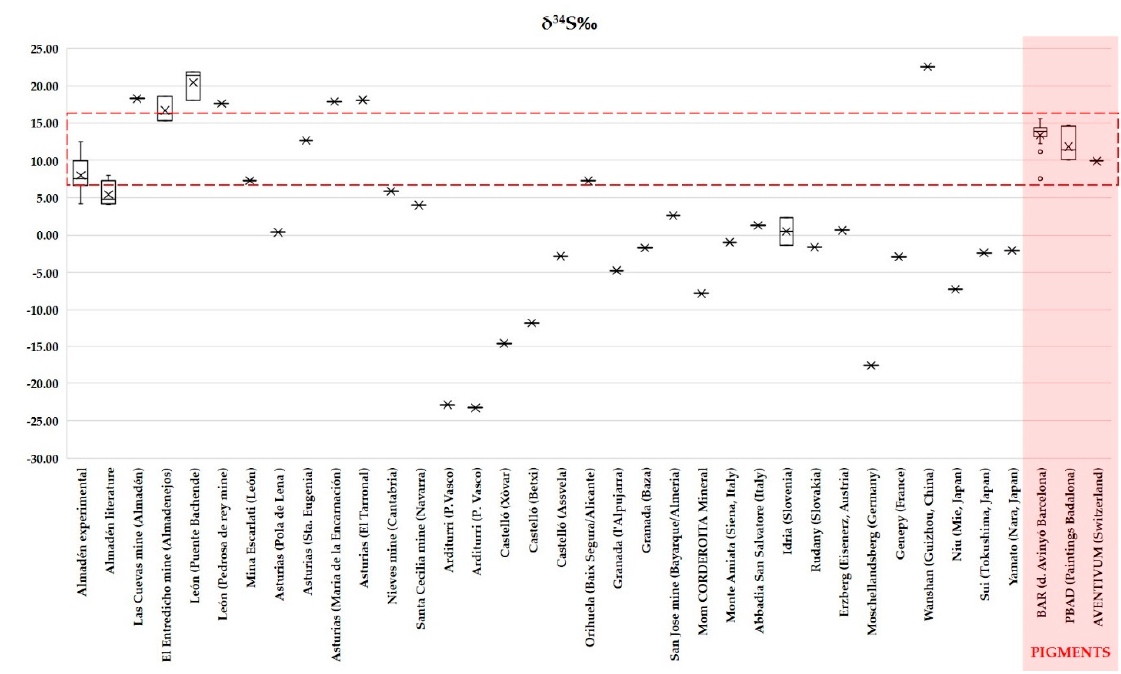
Figure 3. Boxplot of the S isotope values of all the sampled minerals and pigments, also including the values of previous works and those found in the literature.